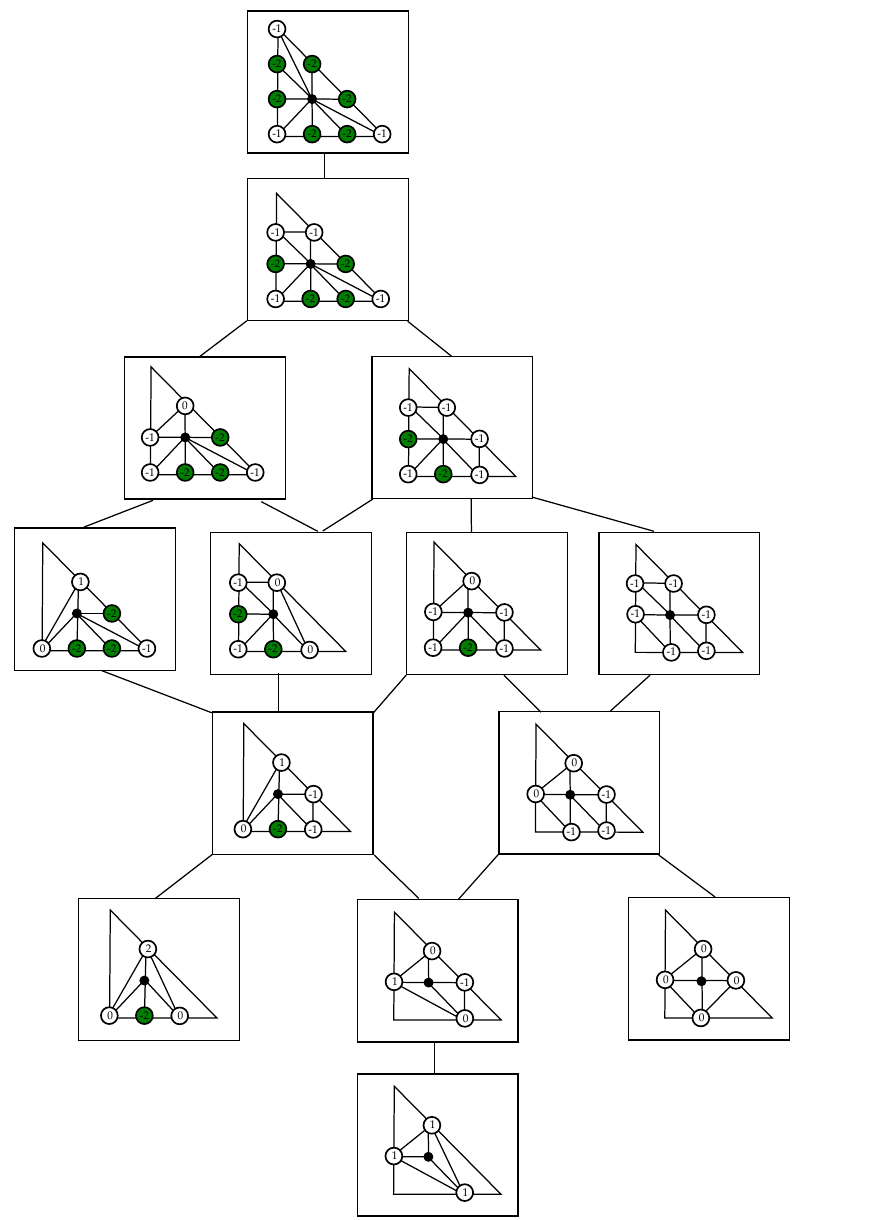
Figure 8 . All CFD-transitions for T 3 : each diagram corresponds to an SCFT that is obtained by mass deformations from the initial T 3 theory. The (cid:13)avor symmetries are read o(cid:11) from the marked (green) subgraphs. For T N with N > 3 this is the non-abelian part of the (cid:13)avor symmetry. For T 3 and its descendants the symmetry is further enhanced as follows from considerations of BPS